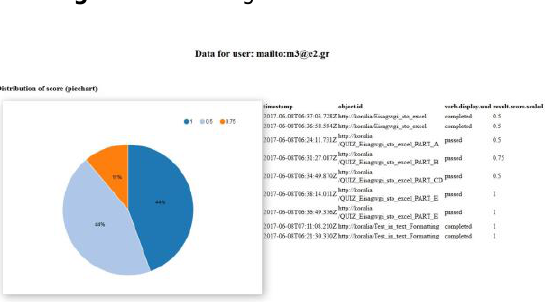
Figure 15. Average Score of students